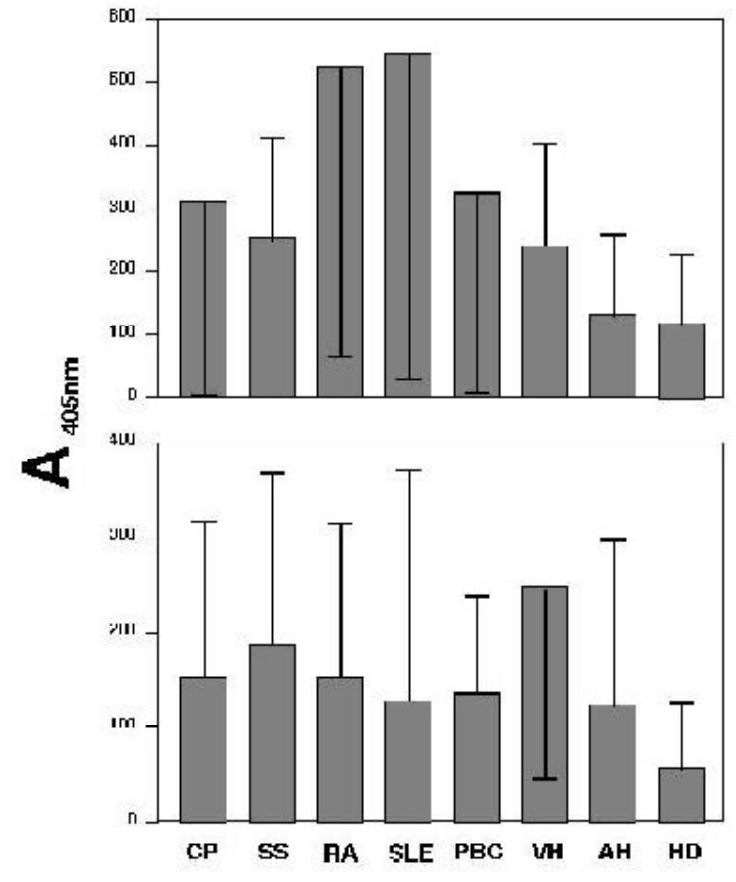
FIGURE 3. Comparison of serum anti-CA-I (above) and anti-CA-II (below) Abs between patients with CP and patients with other immune-mediated liver or systemic diseases. Bars represent the mean absorbance obtained for each patient group. SD are also indicated by vertical lines. CP = chronic pancreatitis (n = 89), SS = Sjögren syndrome (n = 21), RA = rheumatoid arthritis (n = 32), SLE = systemic lupus erythematosus (n = 41), PBC = primary biliary cirrhosis (n = 11), VH = viral hepatitis (n = 25), AH = autoimmune hepatitis (n = 9), HD = healthy donors (n = 72).